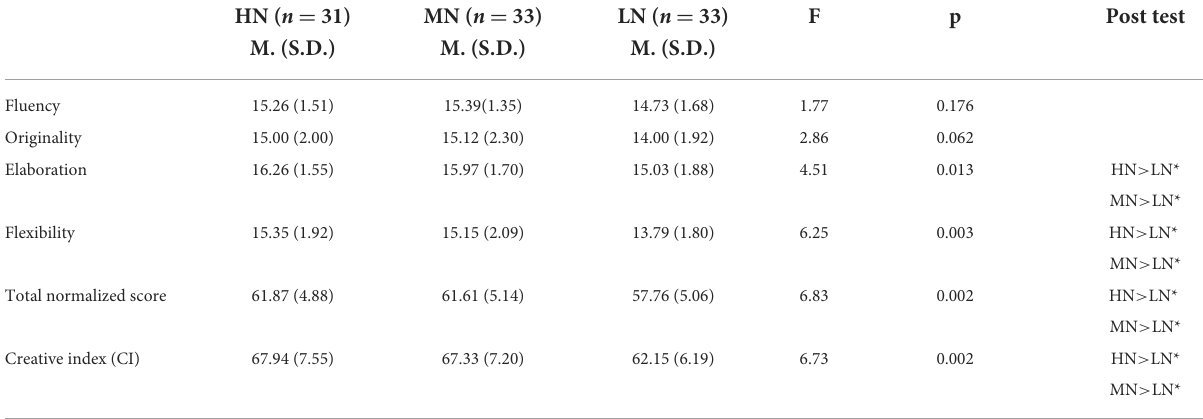
TABLE 4 One-way ANOVA analysis of the overall ATTA normalized score of creativity for environments with different degrees of perceived